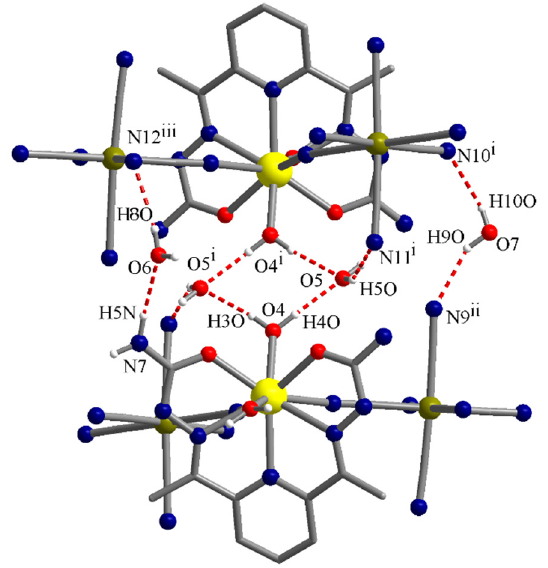
Figure 6. Detail of the packing diagram with the hydrogen interactions established between chains from neighboring supramolecular layers and crystallization water molecules in crystal 2 DyFe (sym- metry codes: i = 1 − x, 1 − y, 1 − z; ii = 1 − x, − 0.5 + y, 1.5 − z; iii = x, 1.5 − y, − 0.5 + z). The shortest intramolecular Fe ··· Gd distances in 1 GdFe are 5.513 and 5.557 Å, while